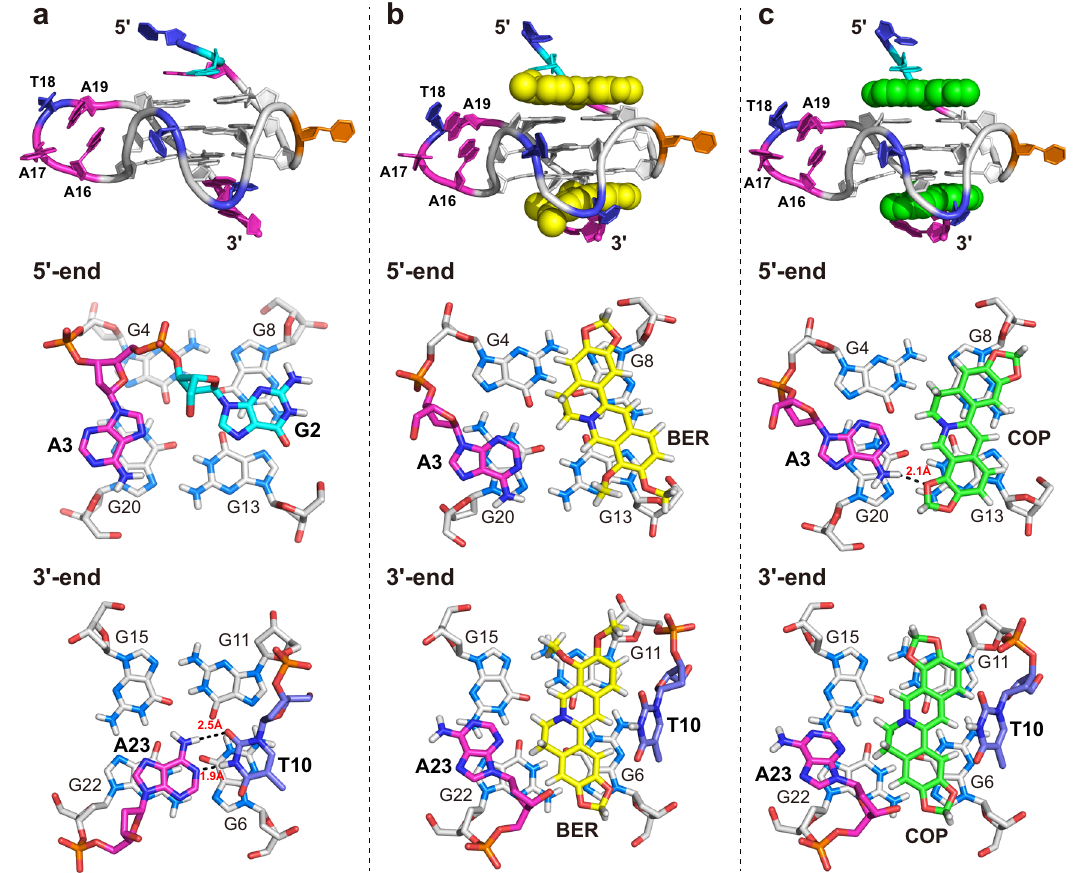
Fig. 5| Solutionstructuredetailsof KRAS -G4and itscomplexeswith berberine and coptisine. Cartoon representation and 5 ′ -end and 3 ′ -end top views of the free KRAS -G4 ( a ), the berberine- KRAS -G4 ( b ), and the coptisine- KRAS -G4 ( c ) complexes